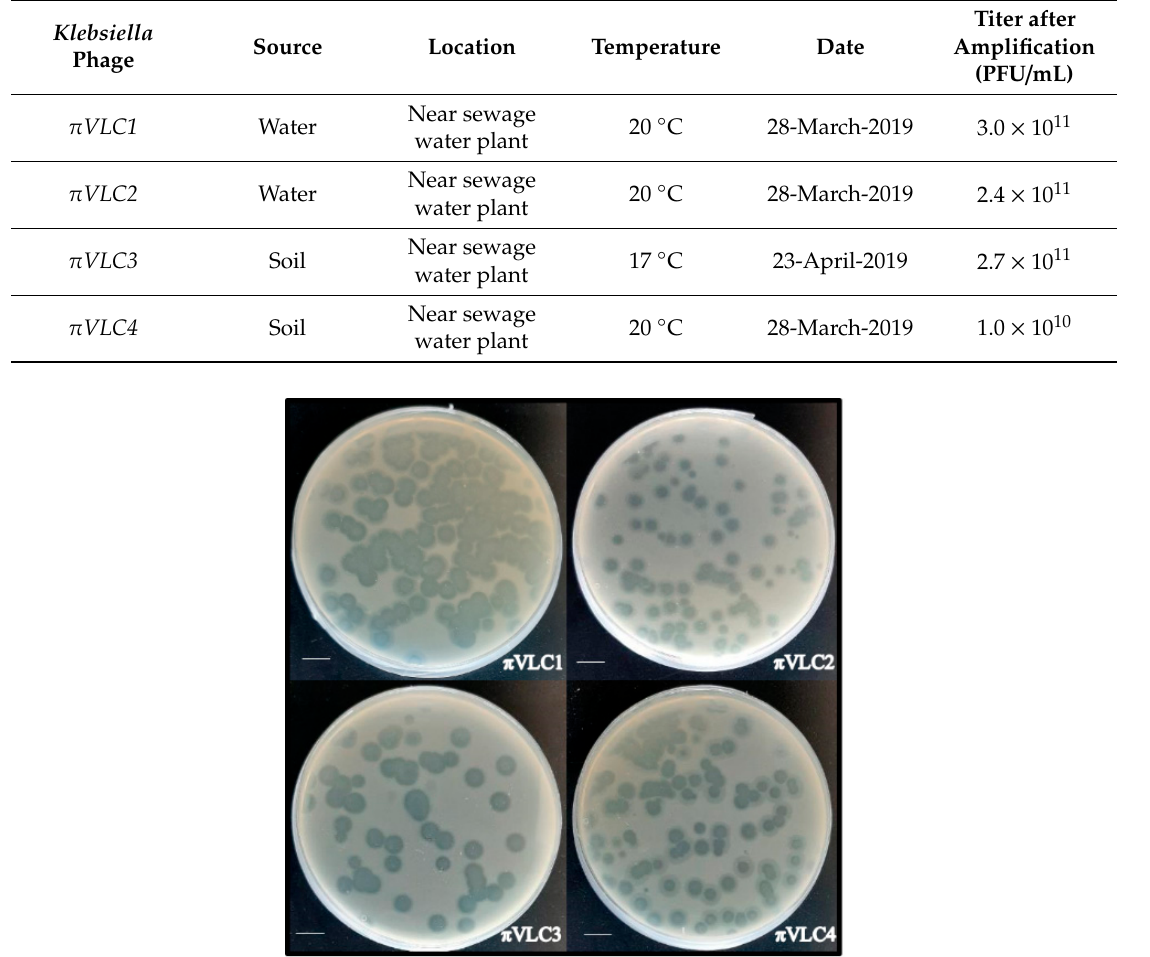
Figure 1. Plaque assays of the four novel K. pneumoniae phages. Plaques were allowed to develop in soft agar media overnight at 37 °C. Scale bar: 1 cm.